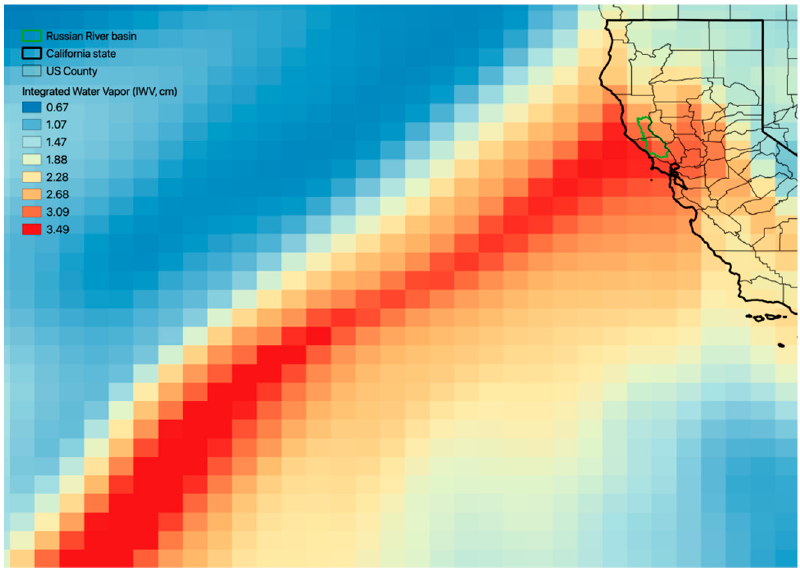
Figure 1. Integrated water vapor (cm) carried by the atmospheric river of 15 February 2004 on the west coast of the United States (US).